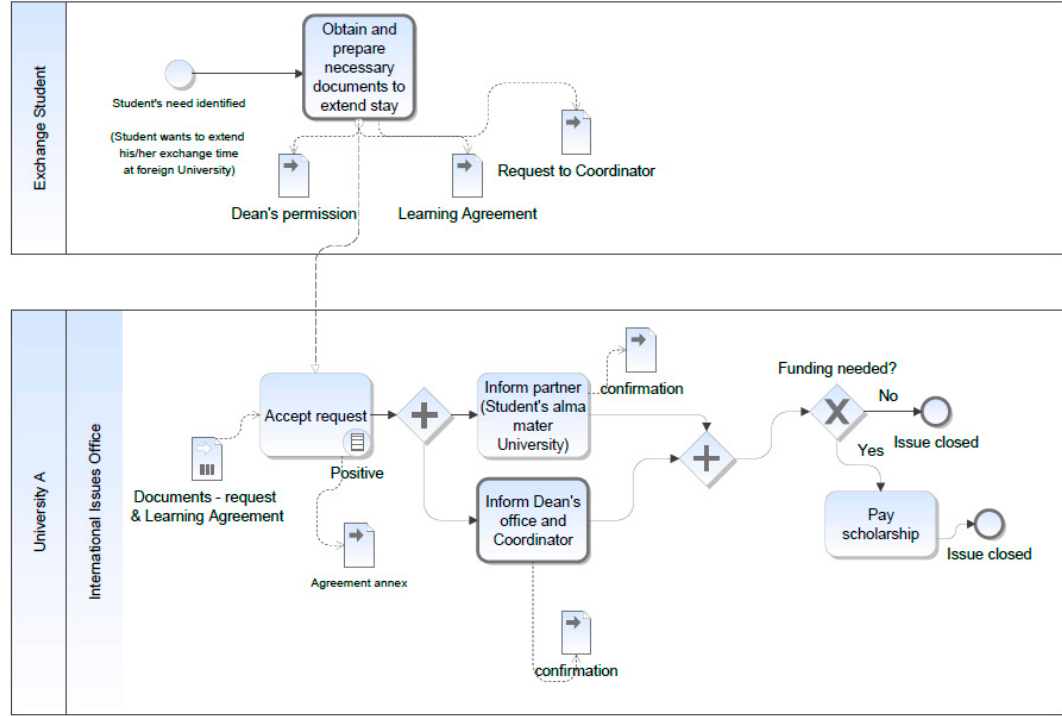
Figure 3. Map of the procedure for extending an exchange student’s stay at a foreign university.